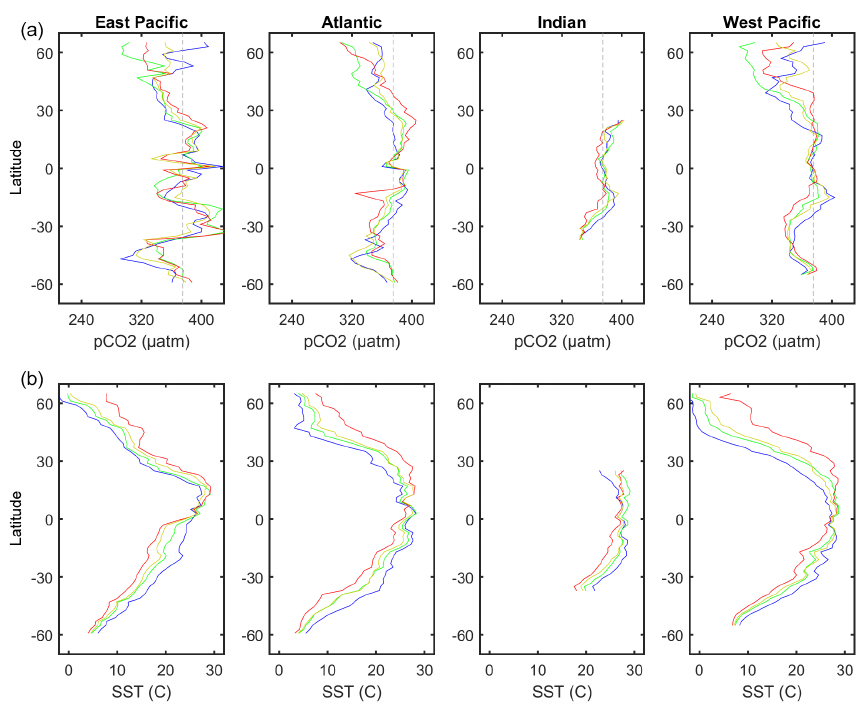
Figure 8. Seasonal-mean latitudinal profiles of p CO 2 (a) and SST (b) for the continental shelves surrounding four oceanic basins. Blue lines: averages over the months of January, February and March; green lines: averages over the months of April, May and June; red lines: averages over the months of July, August and September; yellow lines: averages over the months of October, November and December. The dashed line in the top panels represents the average atmospheric p CO 2 for year